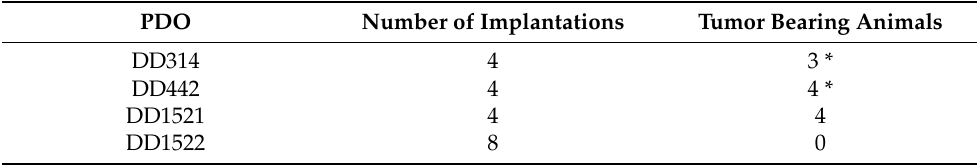
Table 1. Subcutaneous xenograft tumor formation in NMRI Foxn1 nu/nu